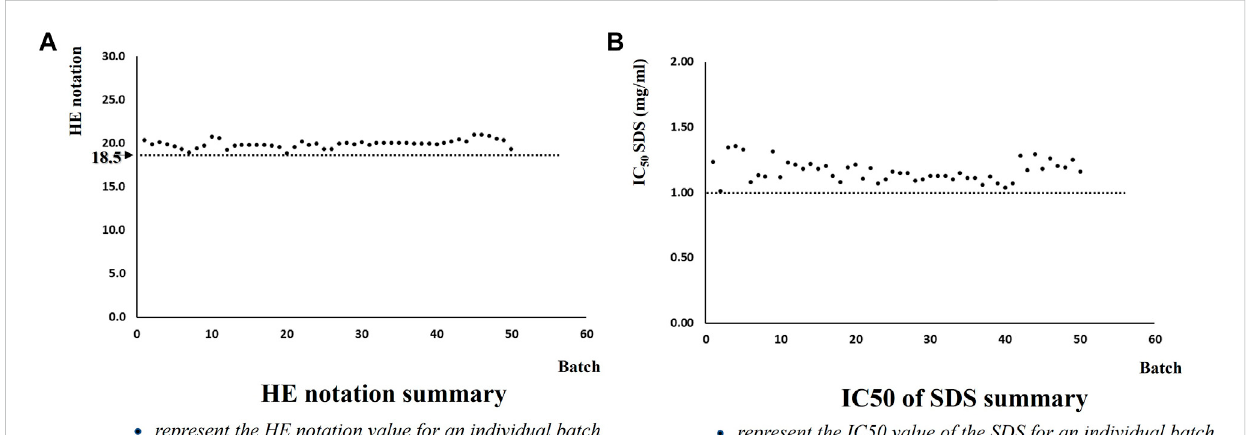
FIGURE 1 Historical QC trend